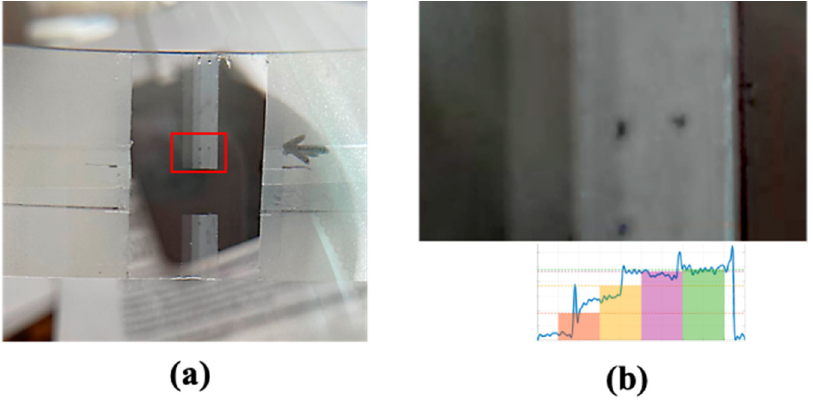
Figure 6. ( a ) Photograph of TPU nanoparticles collected, and ( b ) zoom photograph of the thickness distribution of the deposited TPU film sample (Image ( a )).